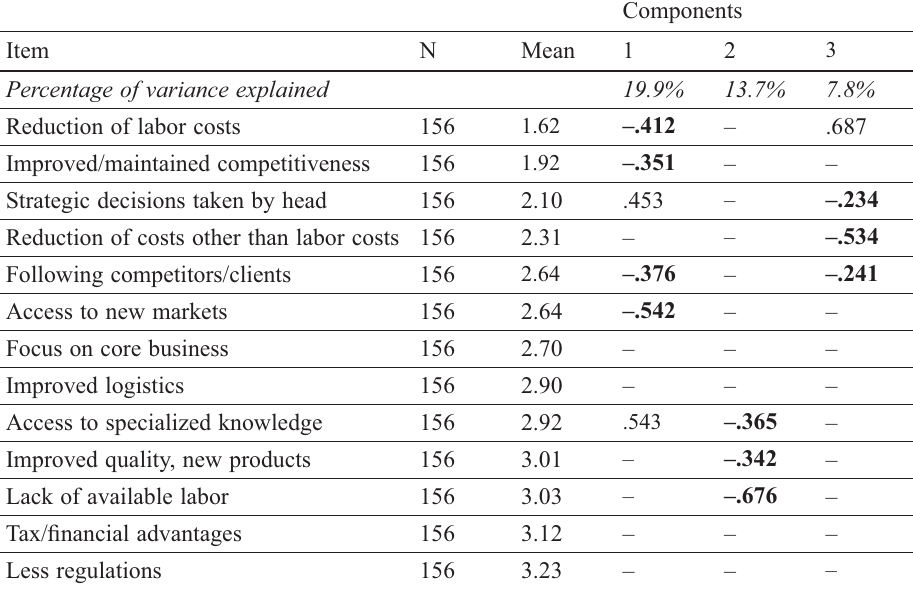
Table 4. Factor analysis for motivations for international outsourcing: core + support activities